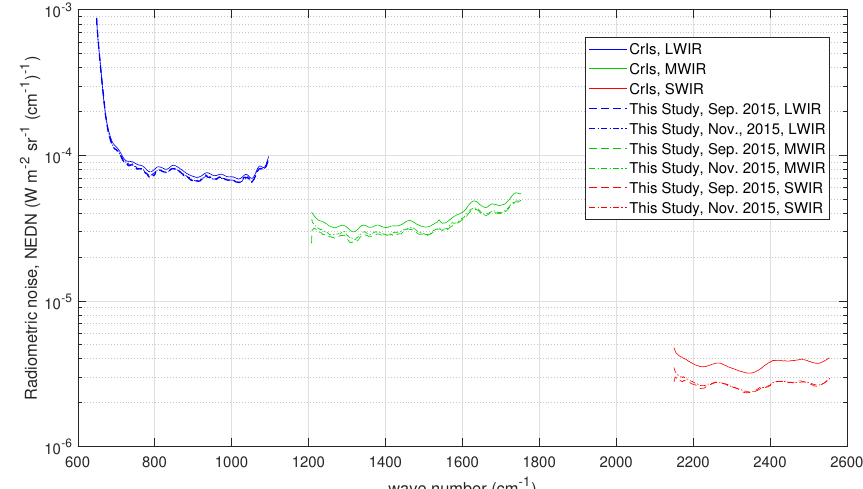
Figure 10. Results for the radiometric noise for the CrIS instrument. The figure also shows the noise used for normalization, which in this case corresponds to the CrIS radiometric noise assessed in [17]. The results have been averaged over the nine CrIS pixels or